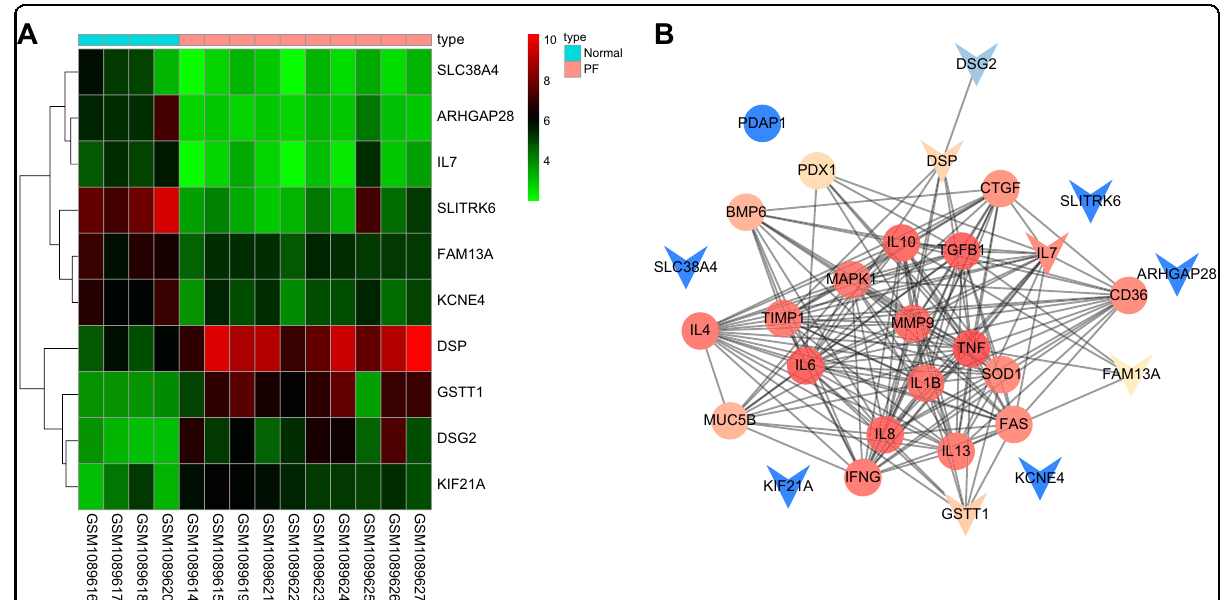
Fig. 1 FAM13A and miR-328 may work in tandem to affect PF . a Heat maps of the top 10 DEGs in the PF gene expression dataset GSE44723. The abscissa suggested the sample number, the ordinate indicated the DEGs, and the right upper histogram indicated the color gradation. Each rectangle in the panel corresponded to one sample expression value. b The interaction network of DEGs and disease genes related to PF, where arrows indicate DEGs, and circles indicate disease genes. miR-328 microRNA-328, FAM13A family with sequence similarity 13, member A, PF, pulmonary fi brosis, and DEGs, differentially expressed